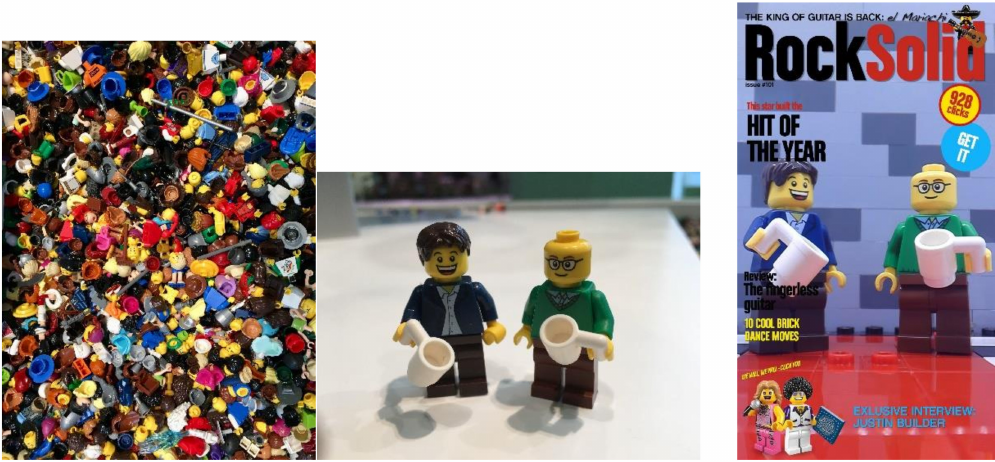
Figure 3. The Character Creator process, from loose LEGO body parts, to minifigures, to the capture